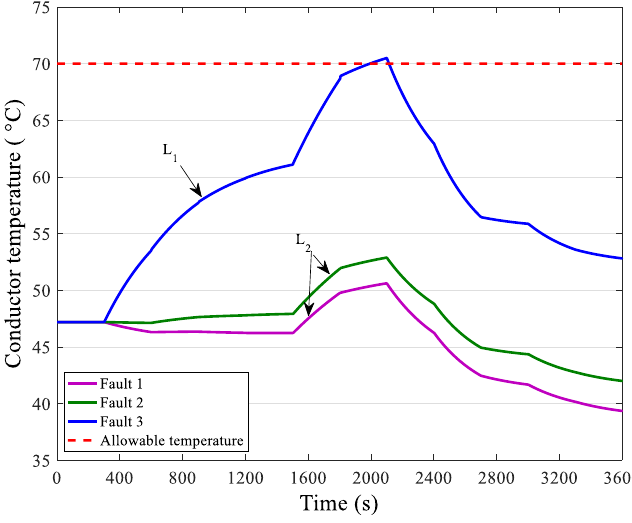
Figure 11. Change of conductor temperature after fault.